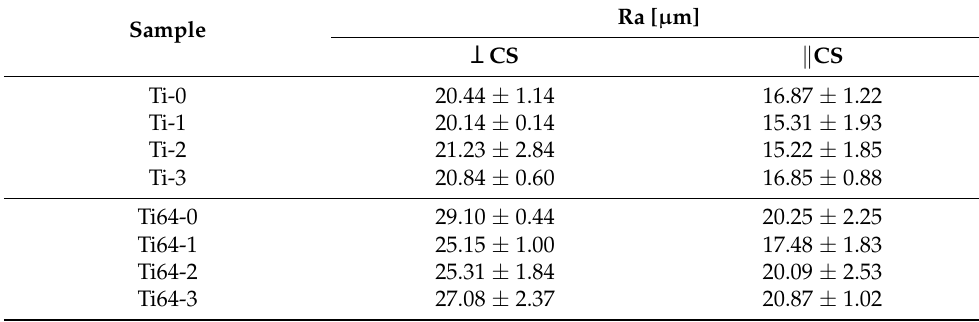
Table 3. Surface roughness measurement results.